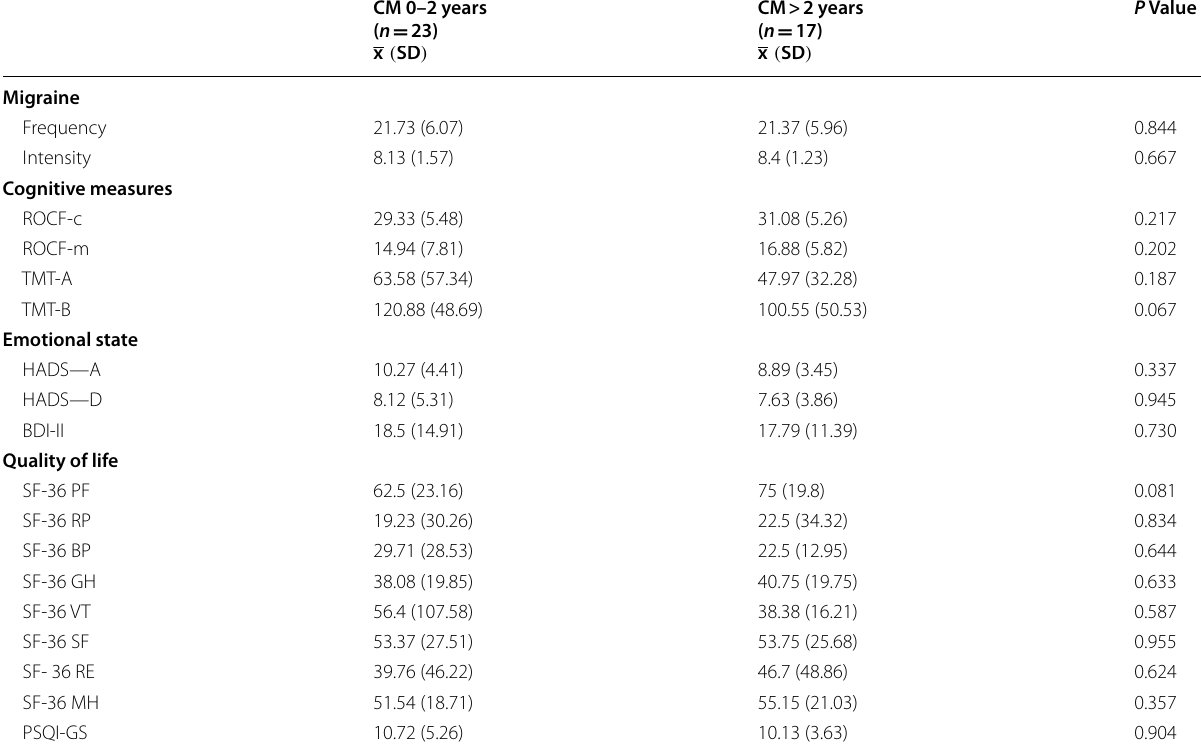
Table 7 Comparison of the parameters analysed in relation to cognition and quality of life in patients with CM with 0–2 years since onset of migraine ( n 23) or patients with CM with > 2 years since onset ( n =